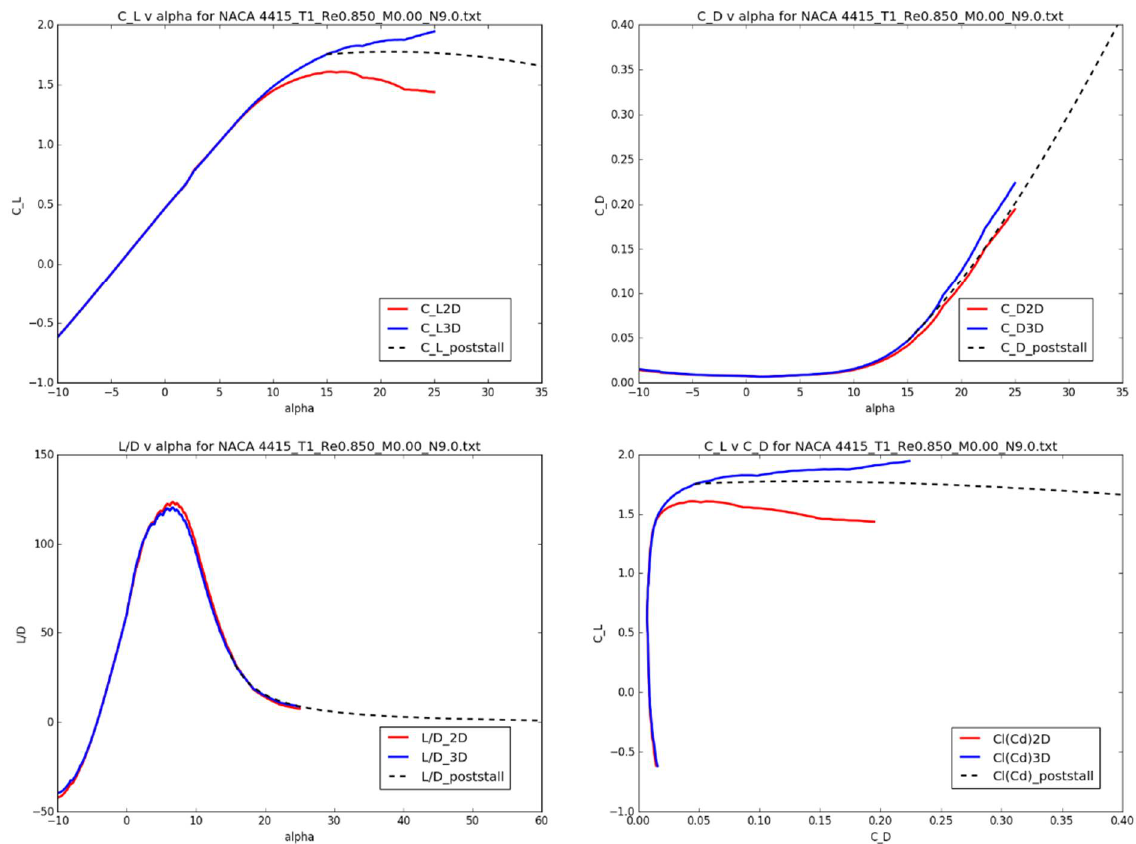
Figure 4. Comparison of polar with (blue) and without (red) 3D rotational corrections for NACA4415 airfoil at REYN = 0.85 × 10 6